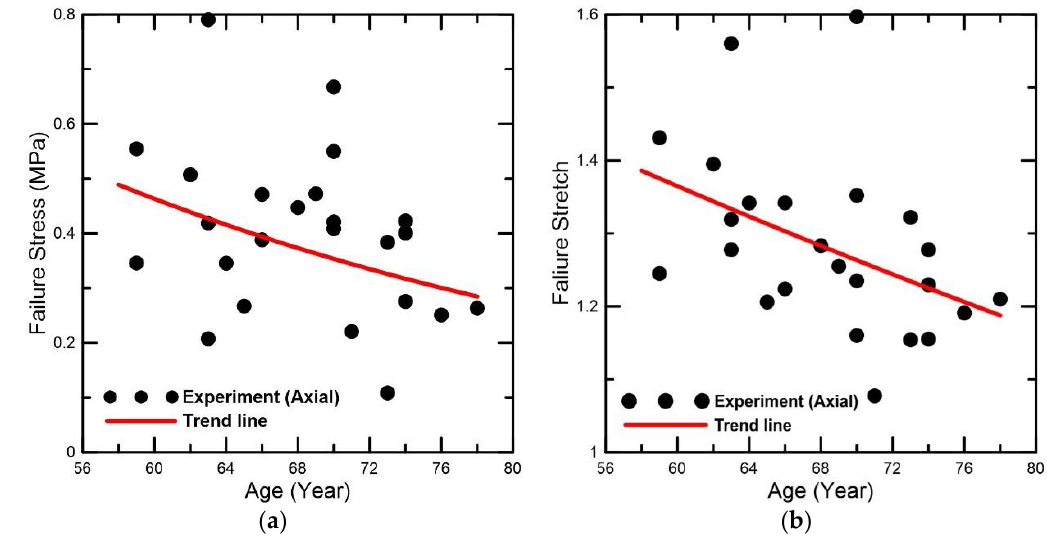
Figure 1. Failure (a) stress and (b) stretch distribution, according to age. Figure 1. Failure ( a ) stress and ( b ) stretch distribution, according to